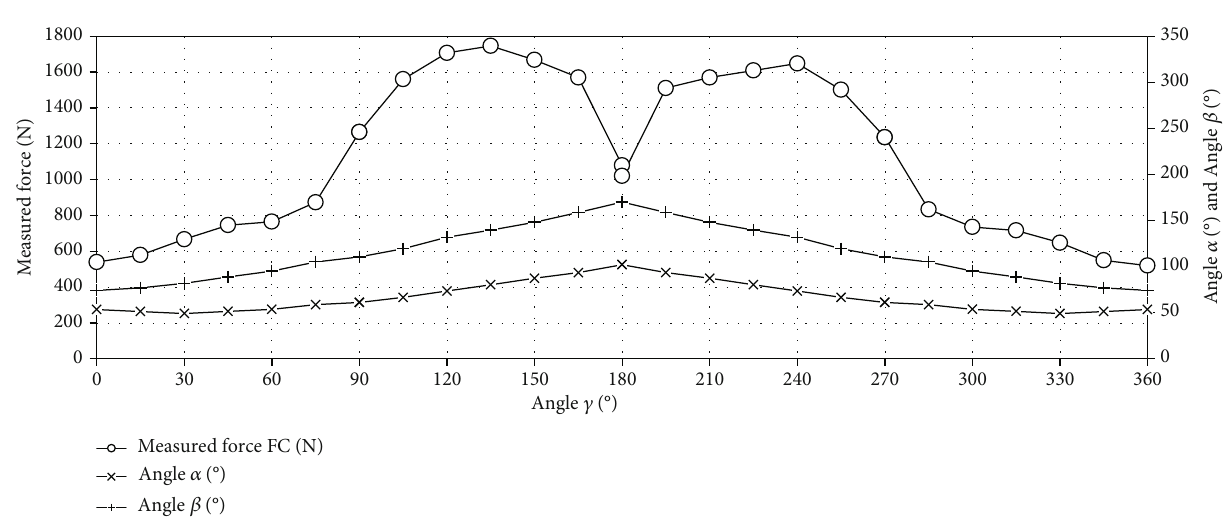
Figure 12: The measured force as a function of the angle γ (the crankset